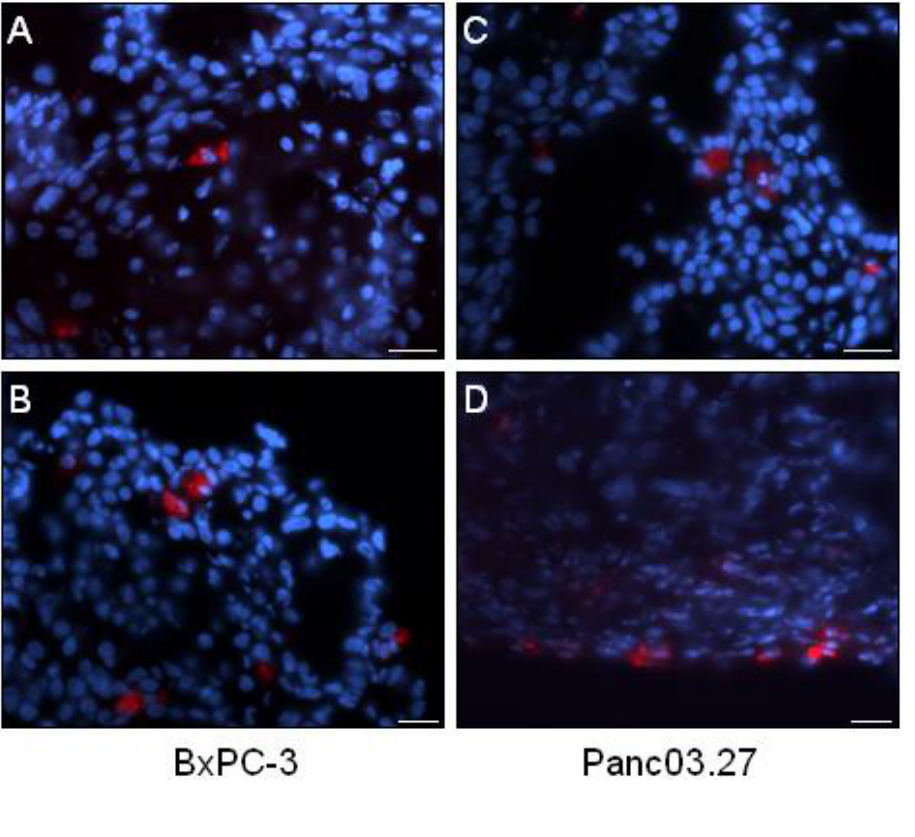
Figure 2. Distribution and Proliferation of DiI+ Cells. ( A - D ) Tumor sections were stained with Dapi (blue) to evaluate the location of DiI+ cells (red). ( A - B ) BxPC-3 tumor sections and ( C - D ) Panc03.27 tumor sections. ( A and C ) single DiI+ cells within the tumor and ( B and D ) on the tumor edges. ( E - H ) Immunohistochemical analysis of the cellular proliferation marker Ki67 (Alexa Fluor 488, green). ( E - F ) BxPC-3 and ( G - H ) Panc03.27 tumor sections. DiI+ cells (red) were confirmed quiescent (Ki67-) whether situated in clusters ( E and G ) or as single cells ( F and H ). Bars represent 20